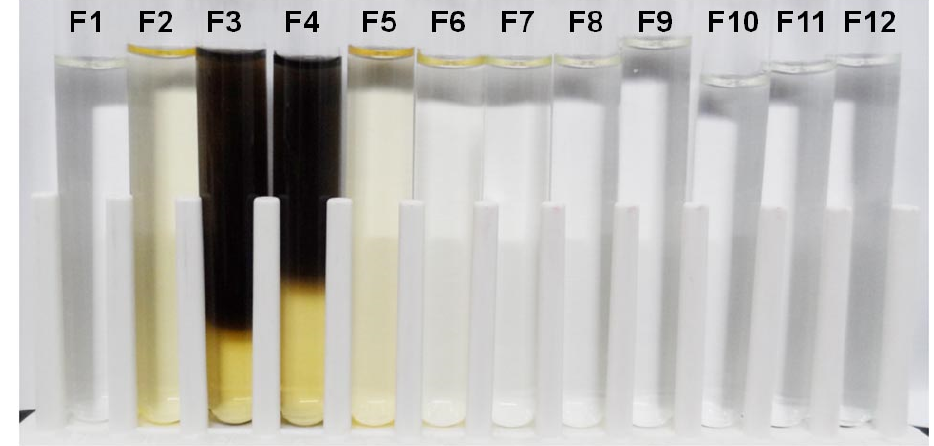
Figure 1. The fruiting body extract fractions (F1–F12) eluted from an ion-exchange column, DEAE-Sepharose, in the edible mushroom Hericium erinaceus , with dark brown pigments in F3 and F4.